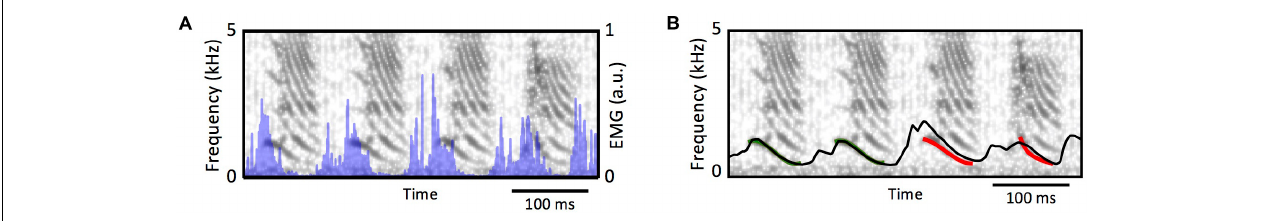
FIGURE 7 | From syringeal muscle activity to acoustic features. (A) The spectrogram of a zebra finch song, and the simultaneous recording of the EMG at the syringealis ventralis muscle (blue traces). (B) , the proxy of the fundamental frequency, as the models in Doppler et al. (2018) are integrated. The red segment was used to tune the parameters, and the black line shows the model’s prediction of the fundamental frequency for the complete song. Adapted from Doppler et al.